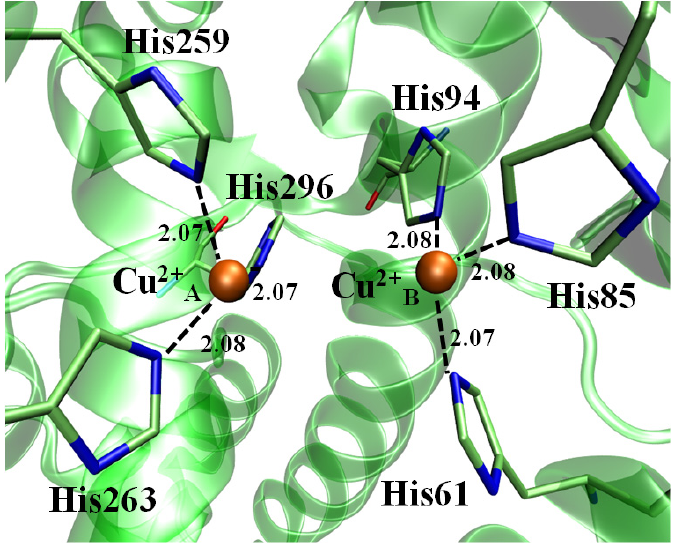
Figure 1. 3D perspective of Ab TYR catalytic site containing two divalent copper cations chelated by His61, His85, His94, His259, His263 and His294 catalytic aminoacid residues. All distances are in